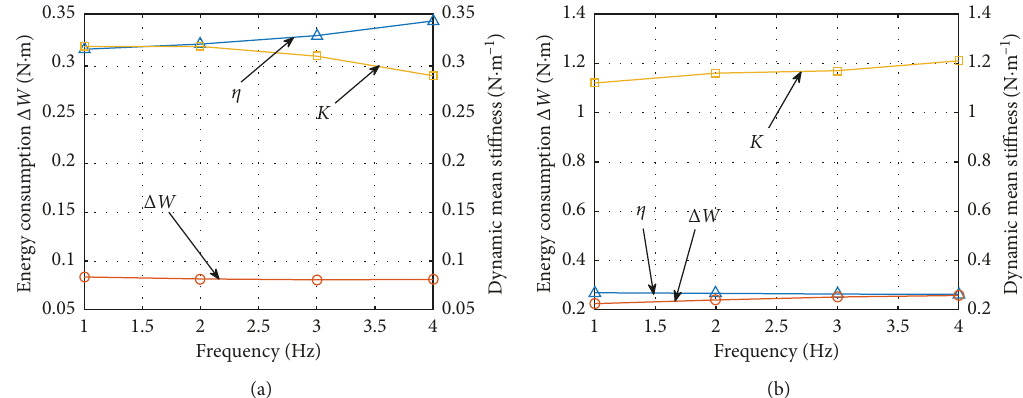
Figure 10: The loss factor, energy dissipation, and dynamic average stiffness variation at different frequencies. (a) MR with the density of 3 . (b) MR with the density of 3.5g 2.5g cm · −